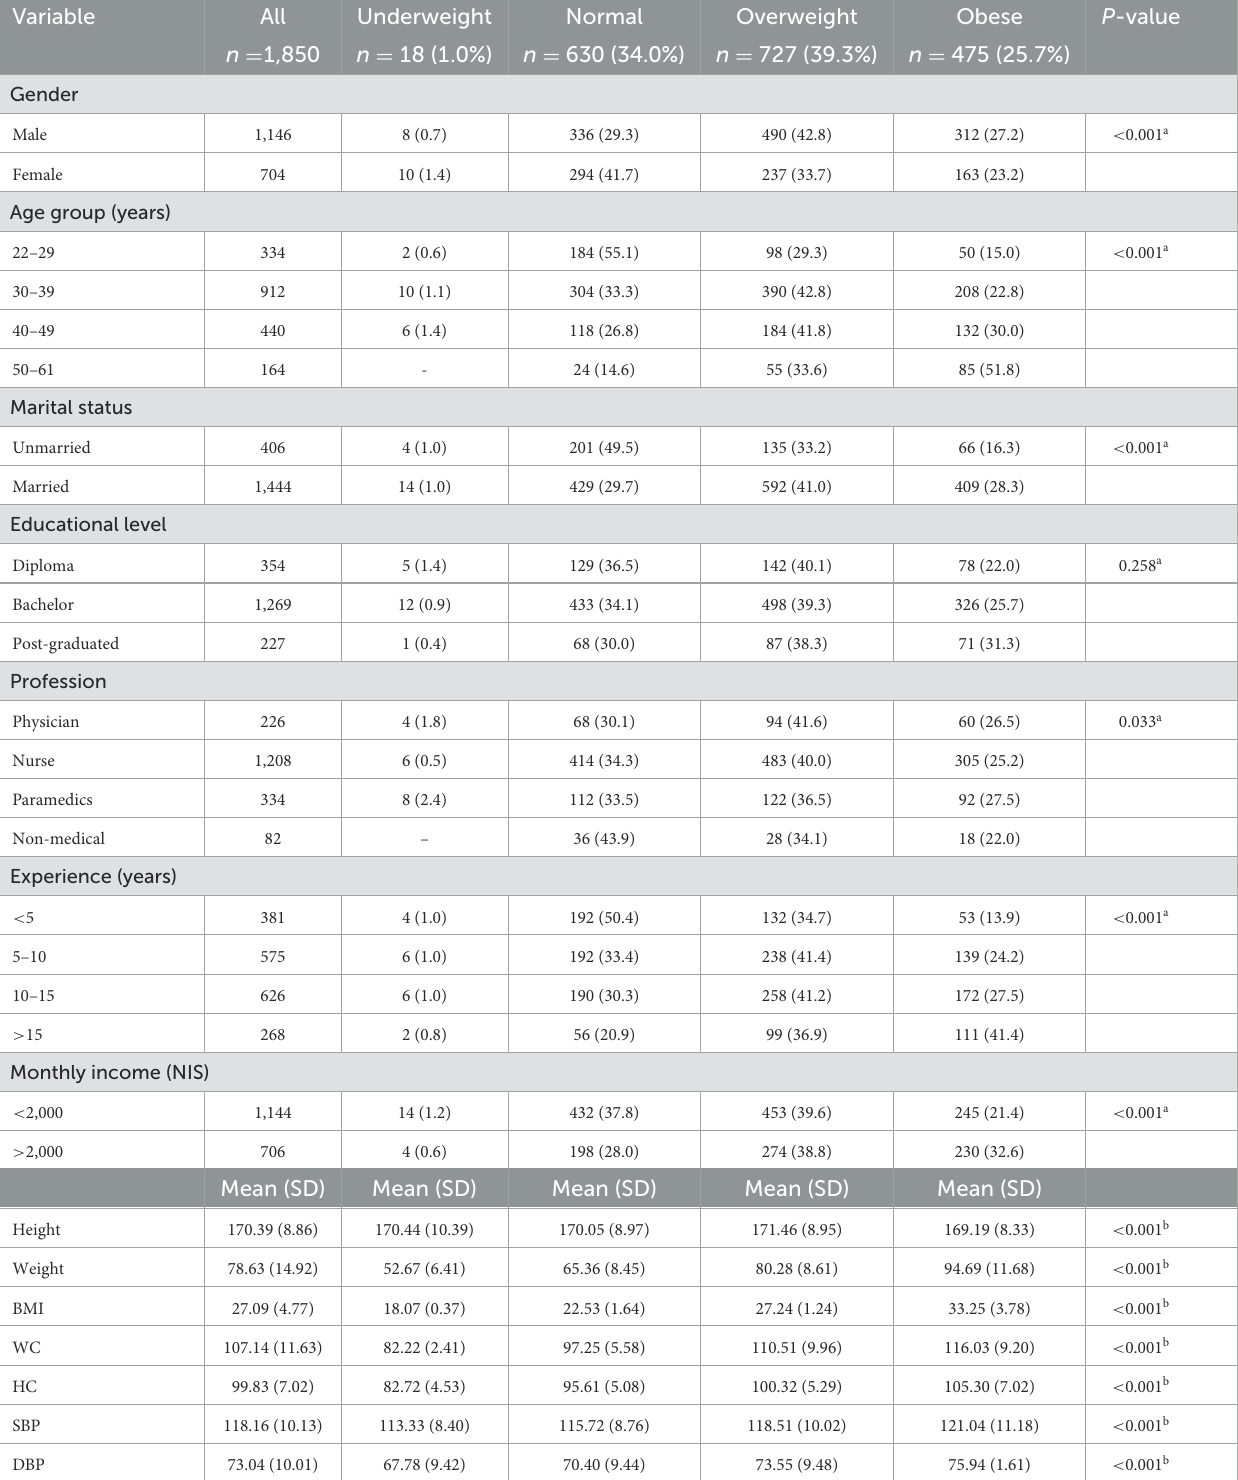
TABLE 1 Baseline characteristics of HCWs in the Gaza Strip by BMI category ( N =